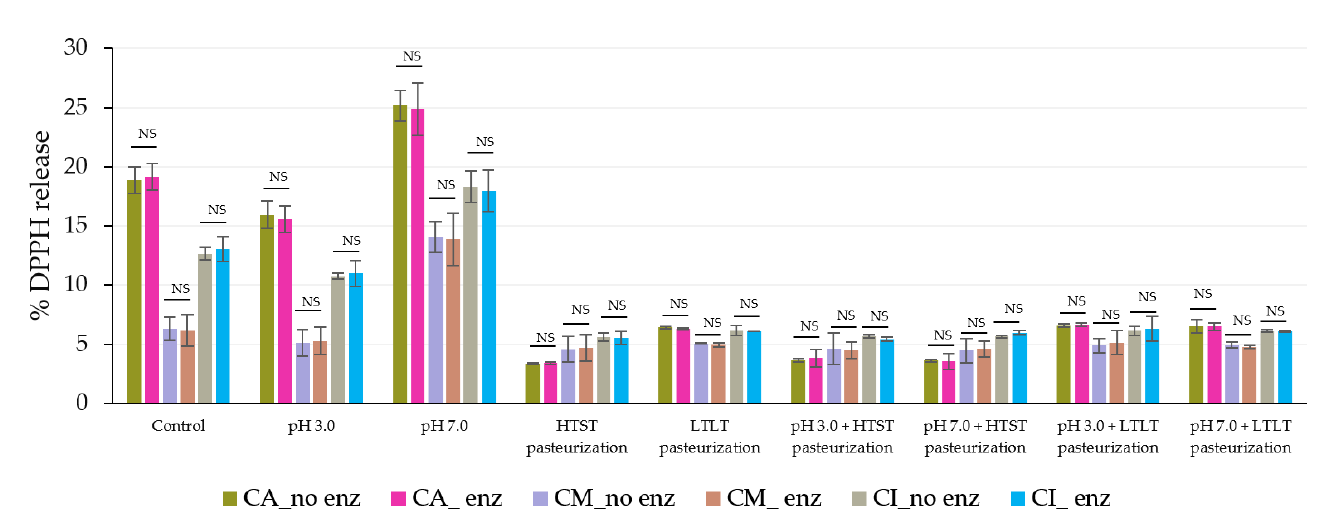
Figure 11. % DPPH released during simulated gastrointestinal conditions in the intestinal phase (120 min) with and without pancreatic and bile salts. NS indicated no significant differences at p ≤ 0.05. The error bars indicate the SD of the data. The control sample was microbeads after air-drying.